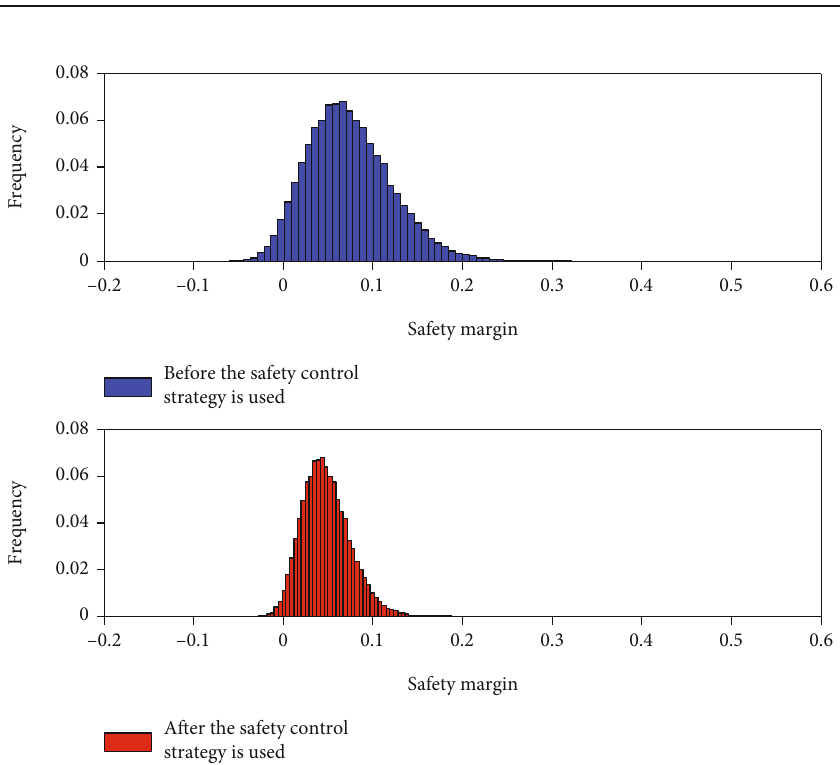
Figure 18: Probability distribution of the safety margin for the turbine inlet temperature Y